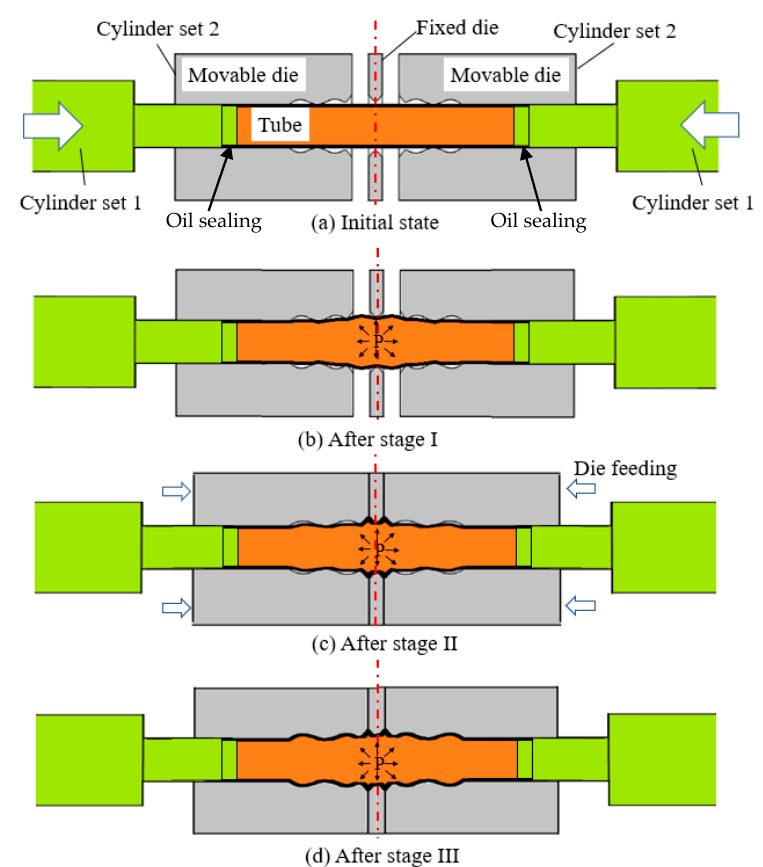
Figure 5. Forming procedures for feeding type 1 with two sets of cylinders (only movement of movable die). ( a )–( d ): Initial State to After Stage III.